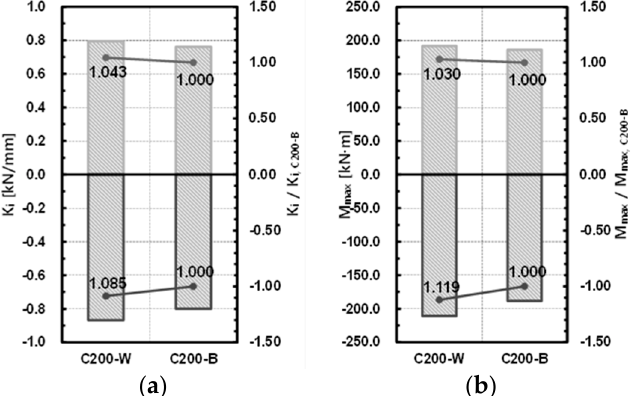
Figure 11. Comparison of a welded joint with a bolted joint. ( a ) Initial stiffness; ( b ) maximum strength.